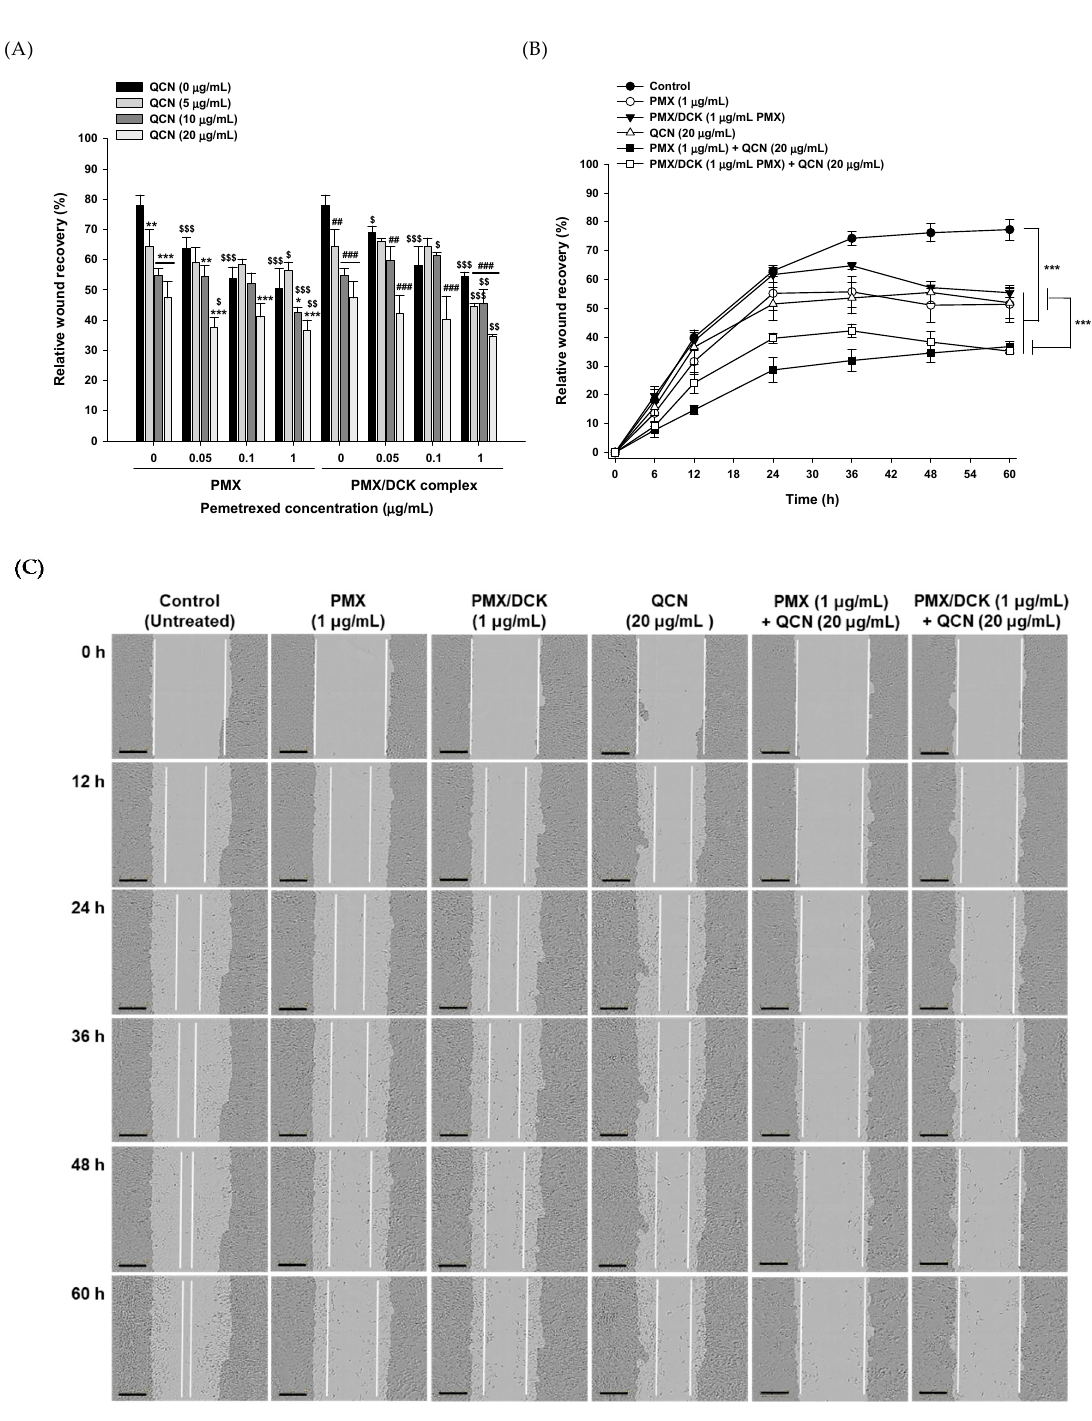
Figure 3. In vitro effects of PMX, PMX/DCK, QCN, and combinations of PMX or PMX/DCK with QCN on the proliferation/migration of A549 cells. ( A ) Wound closure after 48 h treatment ( n = 5; * p < 0.05, ** p < 0.01, *** p < 0.001 compared with PMX alone at the same concentration; ## p < 0.01, ### p < 0.001 compared with PMX/DCK alone at the same concentration equivalent of PMX; $ p < 0.05, $$ p < 0.01, $$$ p < 0.001 compared with QCN alone at the same concentration); ( B ) Time course of closure of the wounded areas after treatment of the cells with PMX, PMX/DCK, QCN, and combinations of PMX or PMX/DCK with QCN ( n = 5; *** p < 0.001); ( C ) Representative images taken at different time points after treatment of the cells with PMX, PMX/DCK, QCN, and combinations of PMX or PMX/DCK with QCN. White lines represent the cell-proliferation/migration progress. Scale bar represents 300 µ